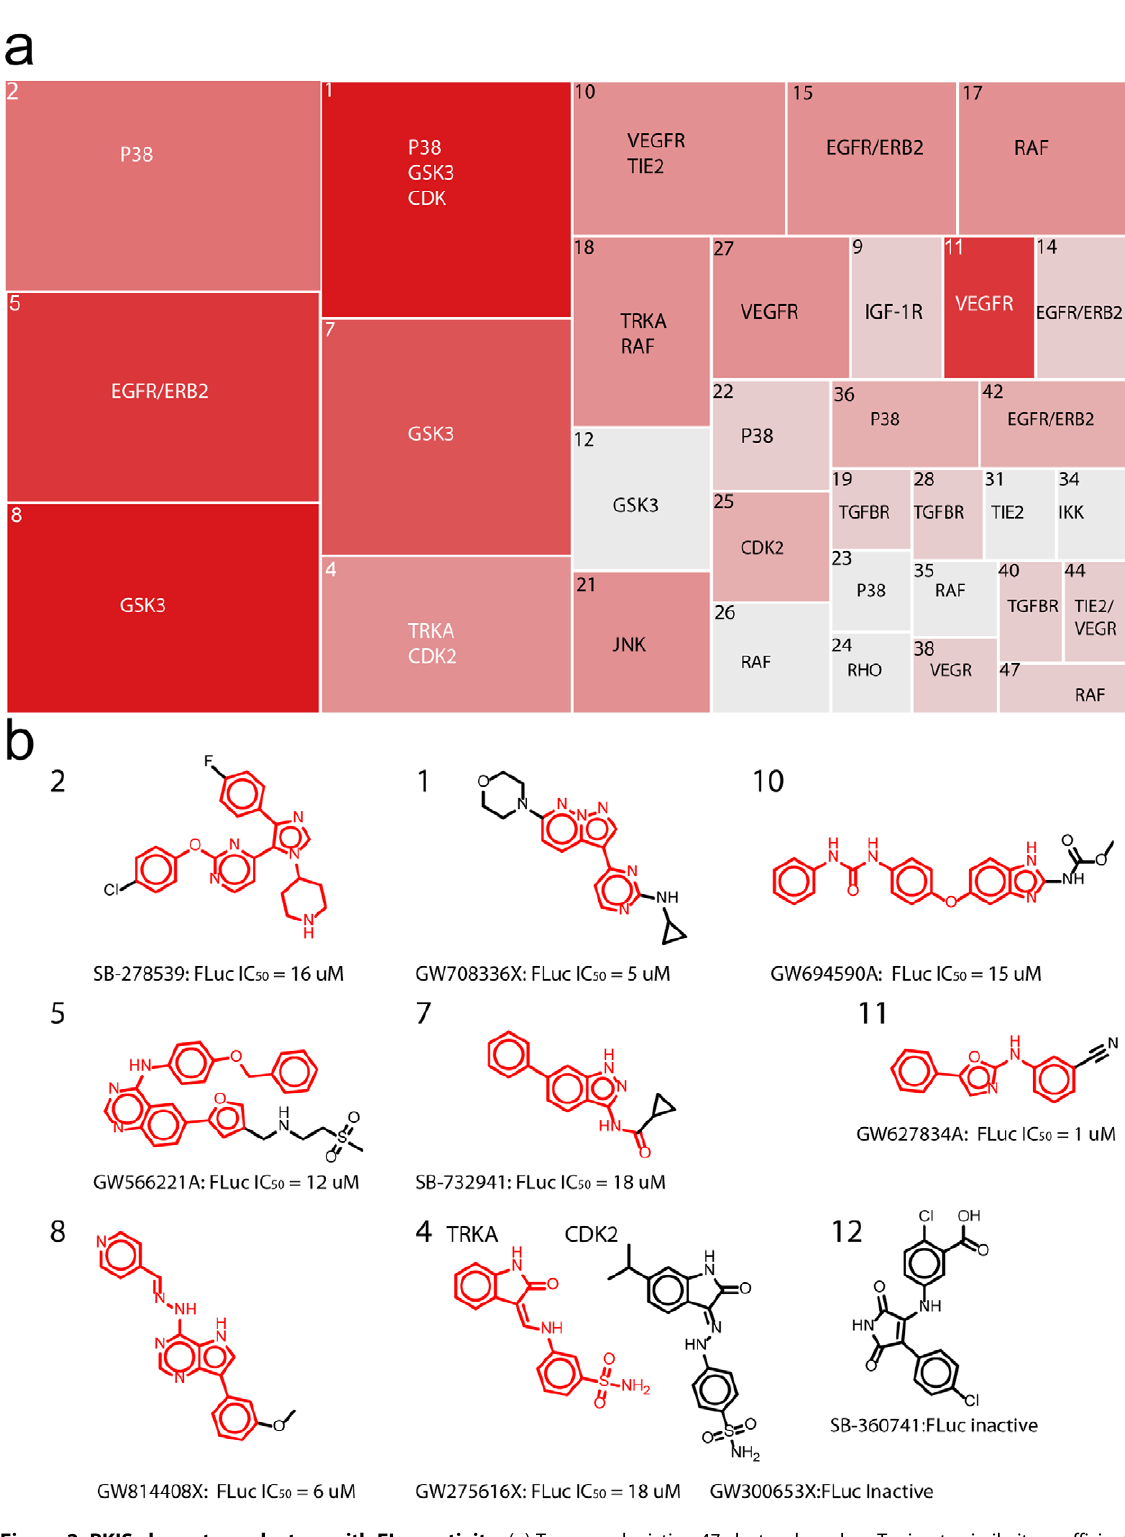
PLOS ONE | www.plosone.org